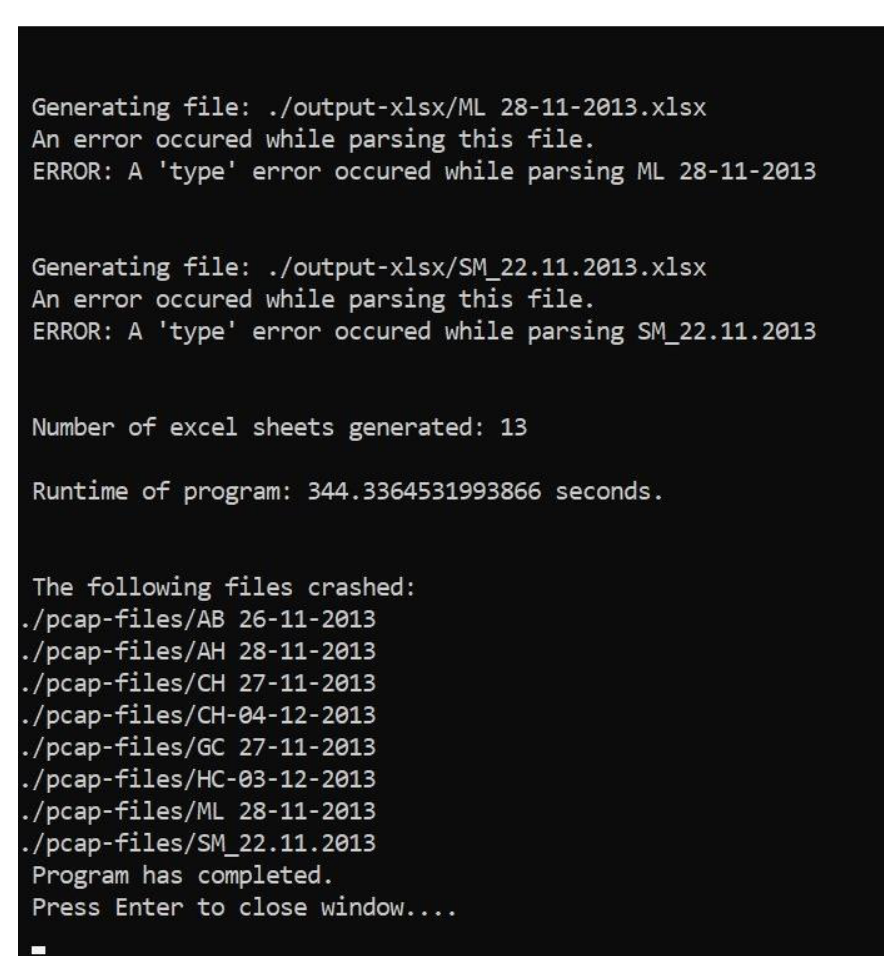
Figure 5. Workflow for raw PCAP file and experimental results for Unique I.P. addresses with Time complexity.